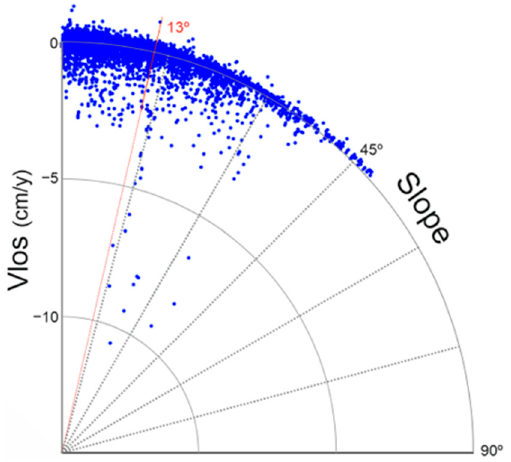
Figure 6. Cross plot of slopes vs. Vlos. The red line shows the 13° threshold from which the largest displacements begin.